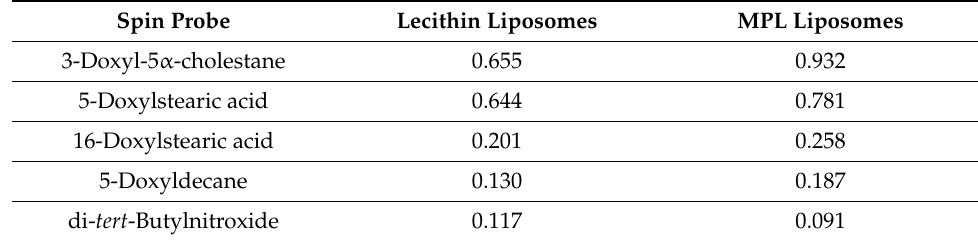
Table 8. Order parameters